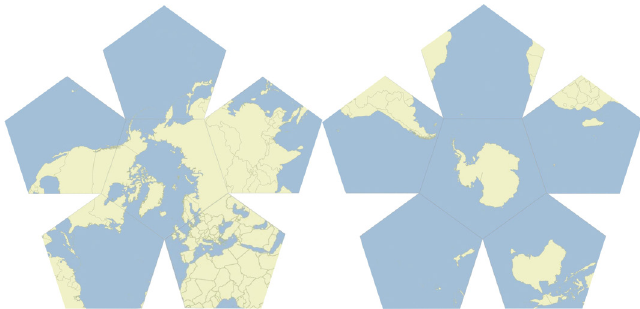
Fig. 28. Map of the World on a dodecahedron